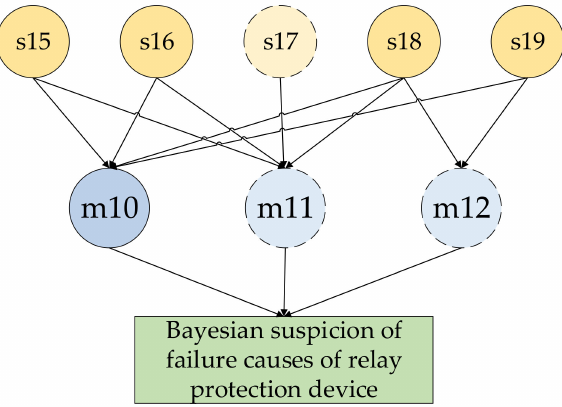
Figure 2. Schematic diagram of Bayesian network for relay protection device fault